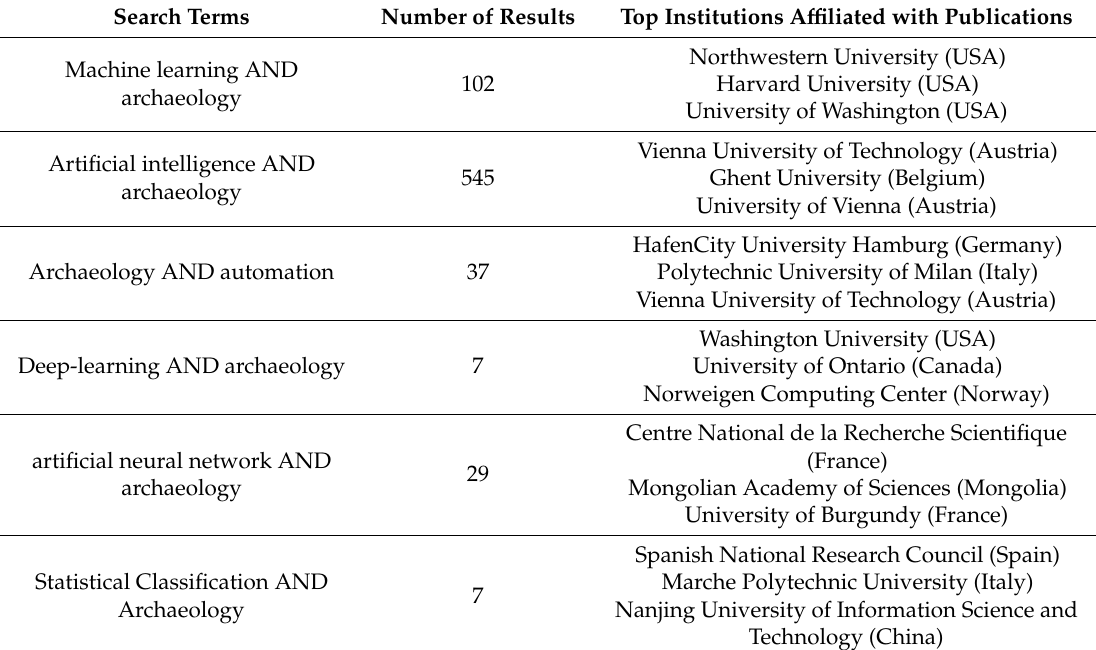
Table 1. Search terms used in Microsoft Academic literature search. Microsoft Academic works using topics, rather than keywords like Web of Science. As such, search terms are not exactly the same as Web of Science (WoS) searches, but encompass the same overall concepts and methods. Results indicate a strong leaning towards North American and Western European